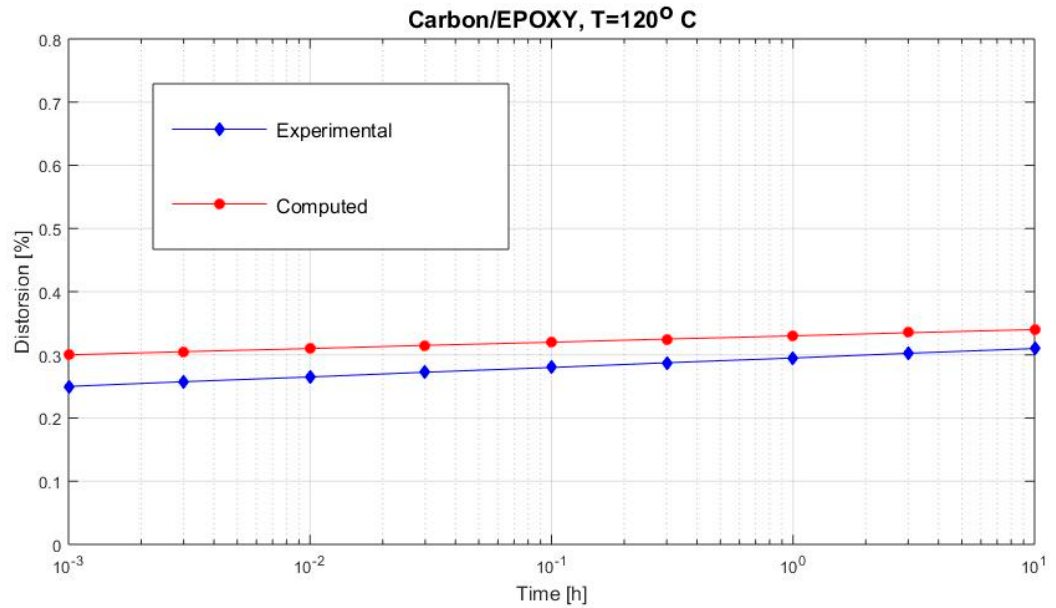
γ (carbon/epoxy subjected to